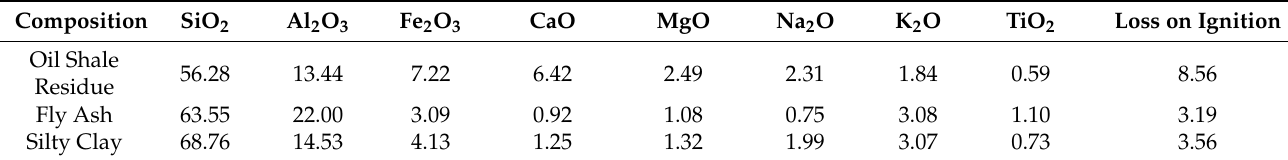
Table 2. Chemical composition of the three raw